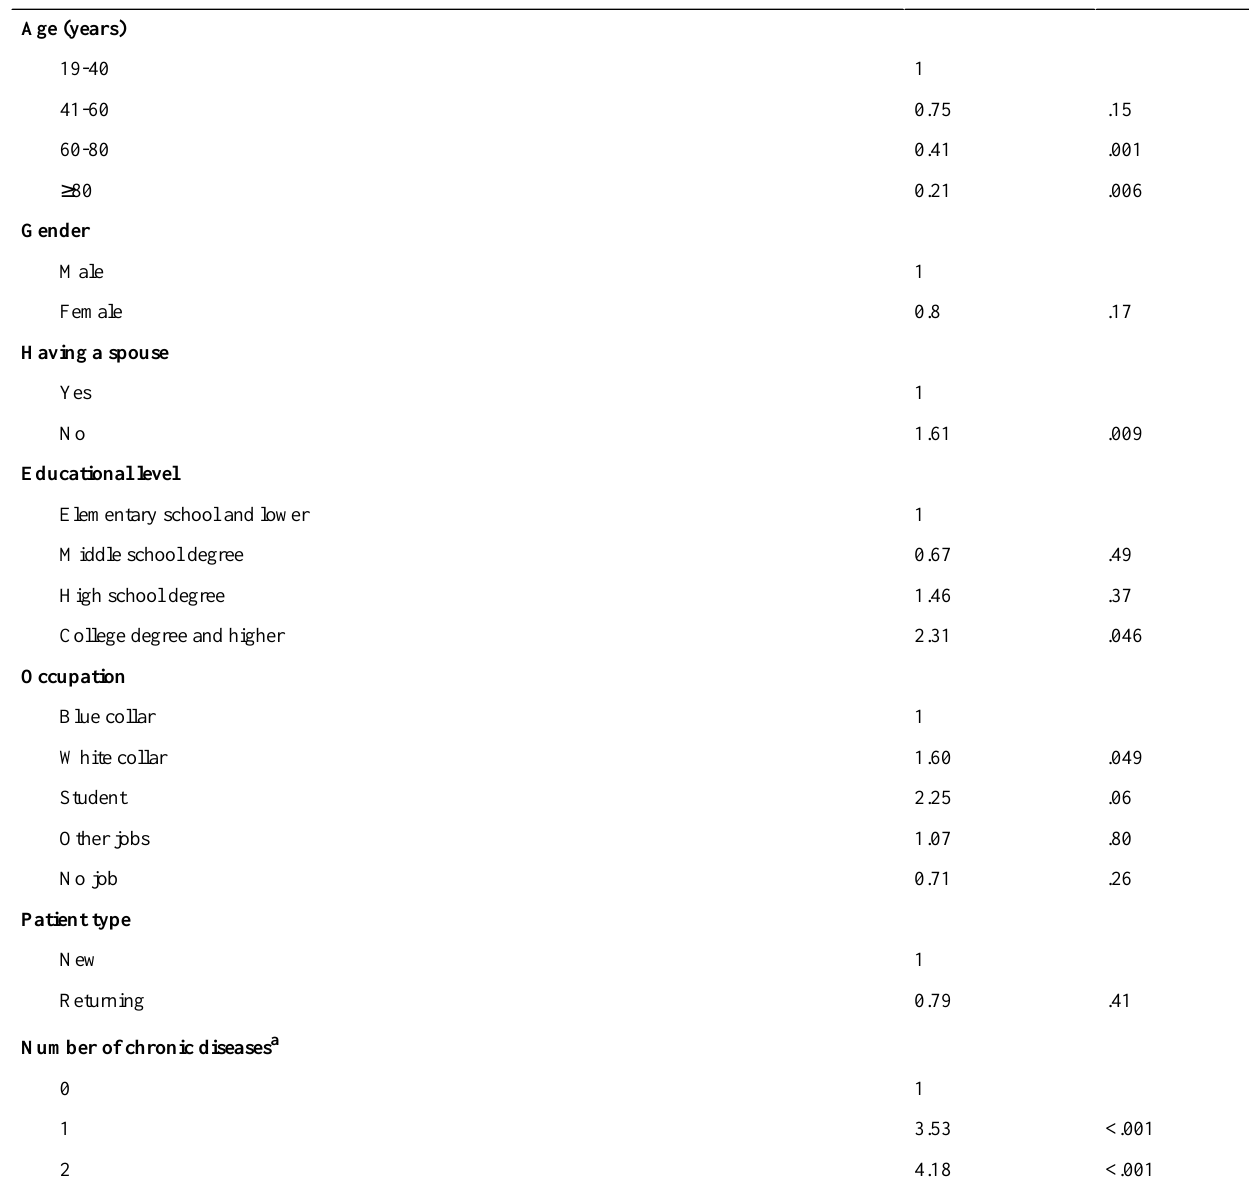
P valueAdjusted odds